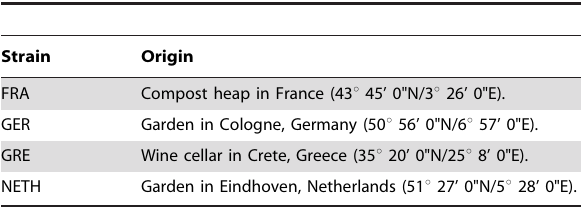
Table 1 . Drosophila melanogaster wild-derived strains used in this study.